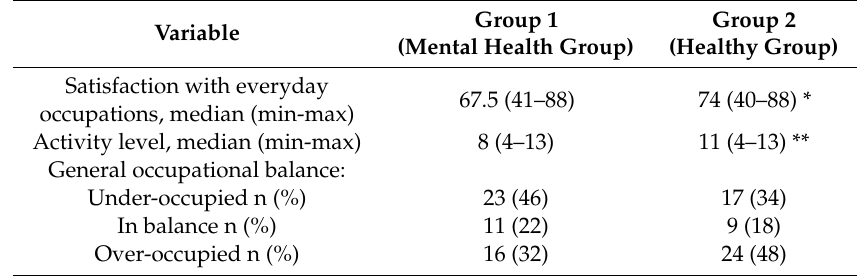
Table 4. Descriptive statistics of scores for satisfaction with everyday occupations scores, activity level and general occupational